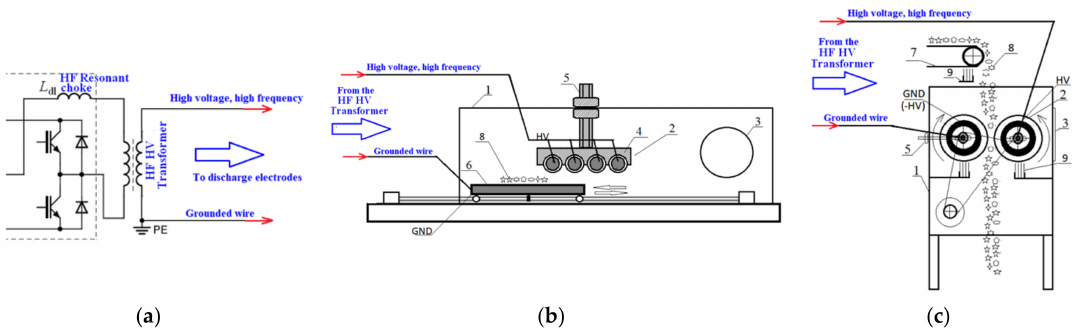
Figure 10. Construction of the devices for decontamination of loose organic material using DBD discharges: ( a ) equivalent diagram of part of a generator with transformer; ( b ) discharge chamber with a sliding electrode; ( c ) discharge chamber with rotating electrodes; 1—discharge chamber, 2—electrodes assembly, 3—suction hole, 4—insulating support, 5—electrodes gap adjustment knob, 6—transport